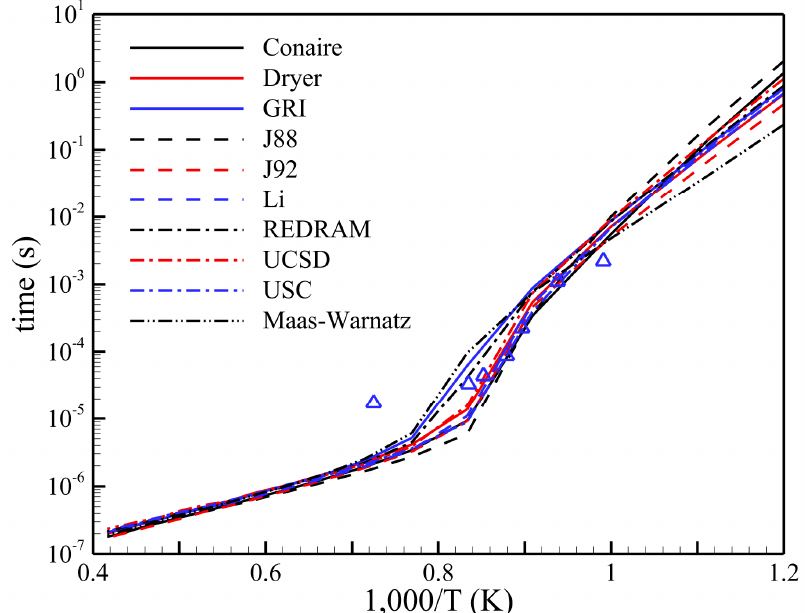
Figure 4. Ignition delays calculated at 10 bar (symbol represents the experimental results from ReSpecTh repository).